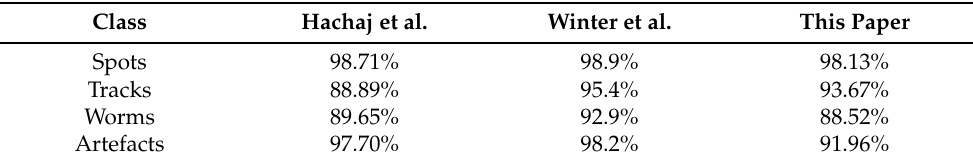
Table 7. Comparison of final results for each class (spots, tracks, worms, artefacts) in selected methods in different works (publications: Hachaj et al. [32], Winter et al. [13] and our model “MLP with one-vs-rest multiclass strategy” from Figure 11i. Class Hachaj et al. Winter et al. This Paper Spots 98.71% 98.9% 98.13% Tracks 88.89% 95.4% 93.67% Worms 89.65% 92.9% 88.52% Artefacts 97.70% 98.2%